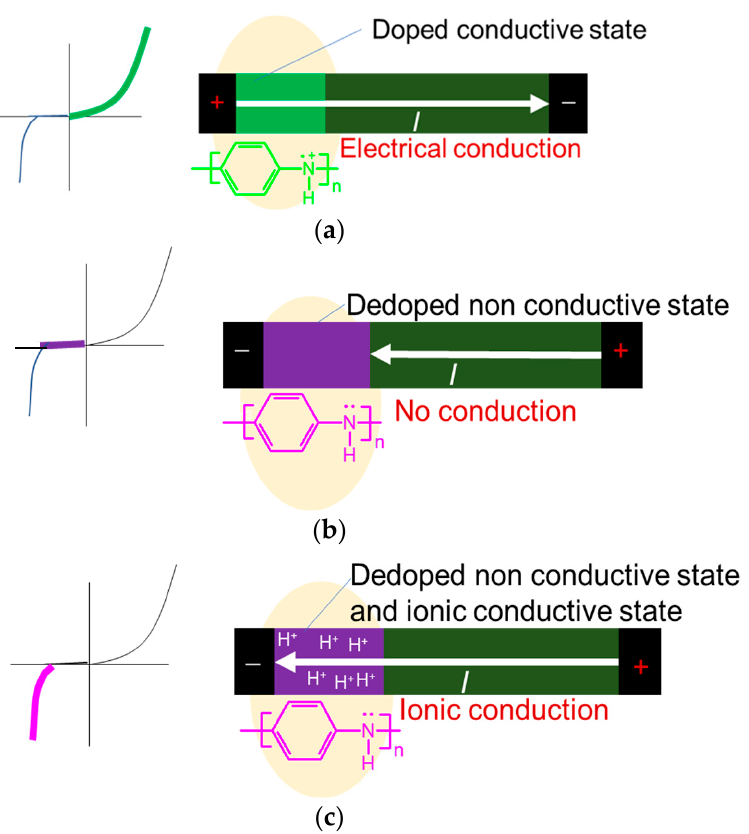
Figure 23. Mechanism of the sprout/PANI avalanche diode. ( a ) 12 to 0 V (electrical conduction state; green line), ( b ) 0 to − 9 V (non-conduction state; purple line), and ( c ) − 9 to − 12 V (ionic conduction state; pink line).